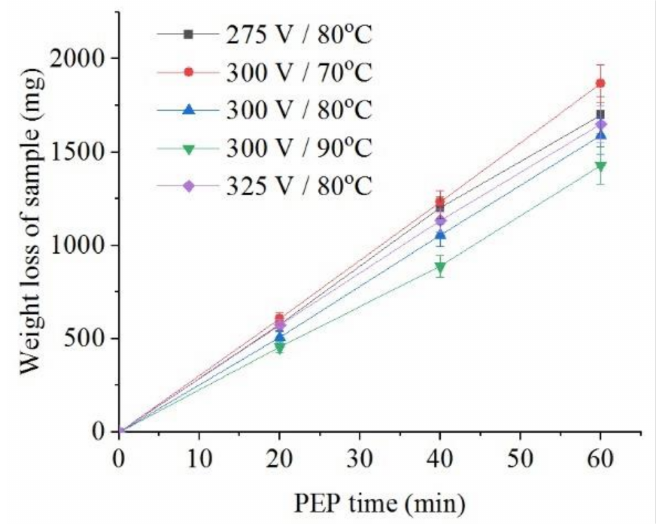
Figure 8. Dependence of the weight loss of the nitrided samples on the PEP duration in ammonium sulfate (3%) solution under natural convection of electrolyte conditions at different voltages and electrolyte temperatures.